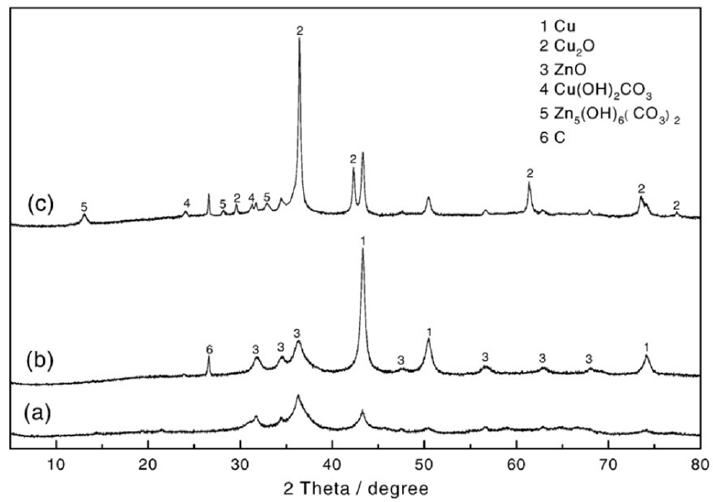
Figure 8. XRD results of Cu/ZnO catalyst: ( a ) reduced Cu/ZnO before catalytic processes, ( b ) after DME synthesis process without water addition, and ( c ) after DME synthesis process with water addition. Reproduced from [83] with Elsevier copyrights license. Ch. Lung Chiang et al. [79], using the XRD technique, showed that, for the CuO– Al 2 O 3 catalyst with CuAl 2 O 4 , an increase in the number of copper particles occurs after the reaction due to the reduction of the particles to Cu. These particles are reduced to Cu upon contact with H 2 , formed from the decomposition of methanol. The formation of H 2 is